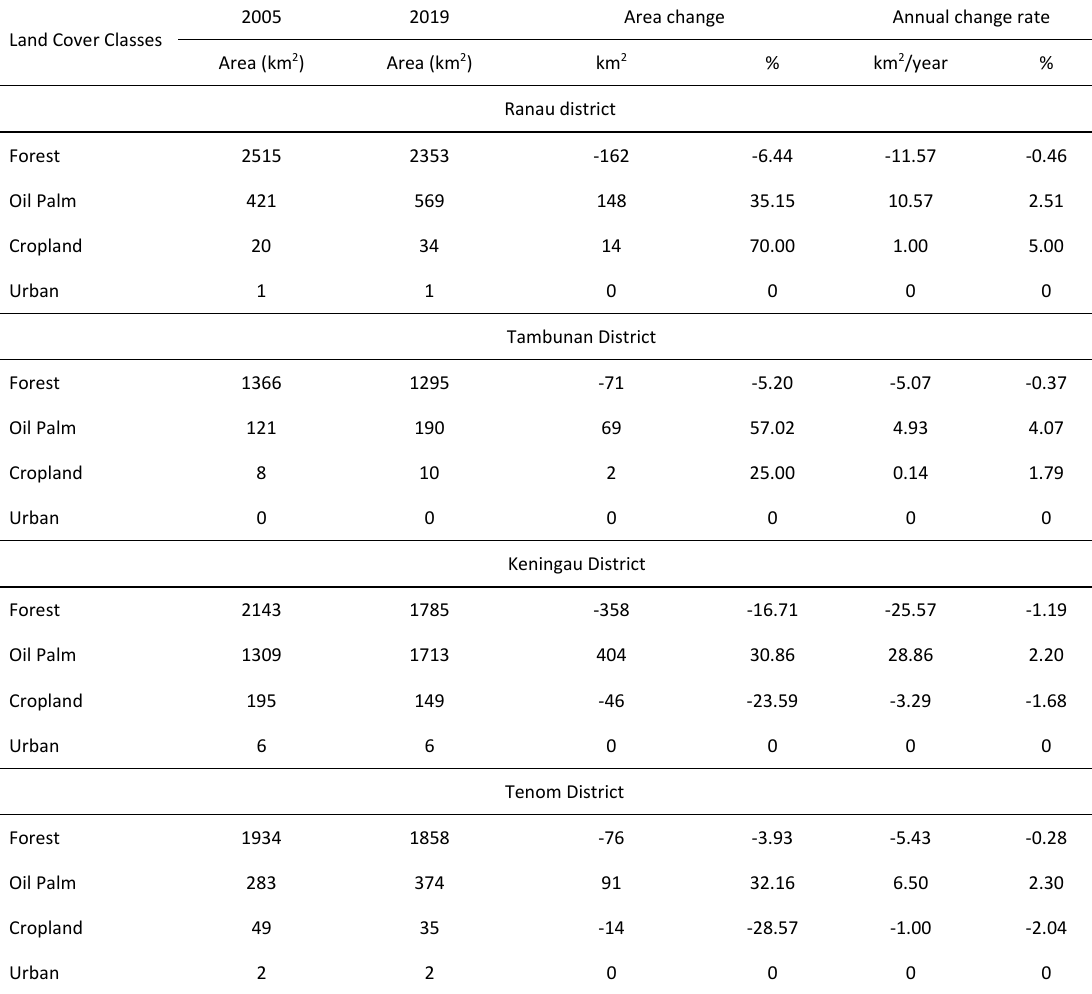
Table 2: Land cover change for each district from the year 2005 to 2019 Land Cover Classes